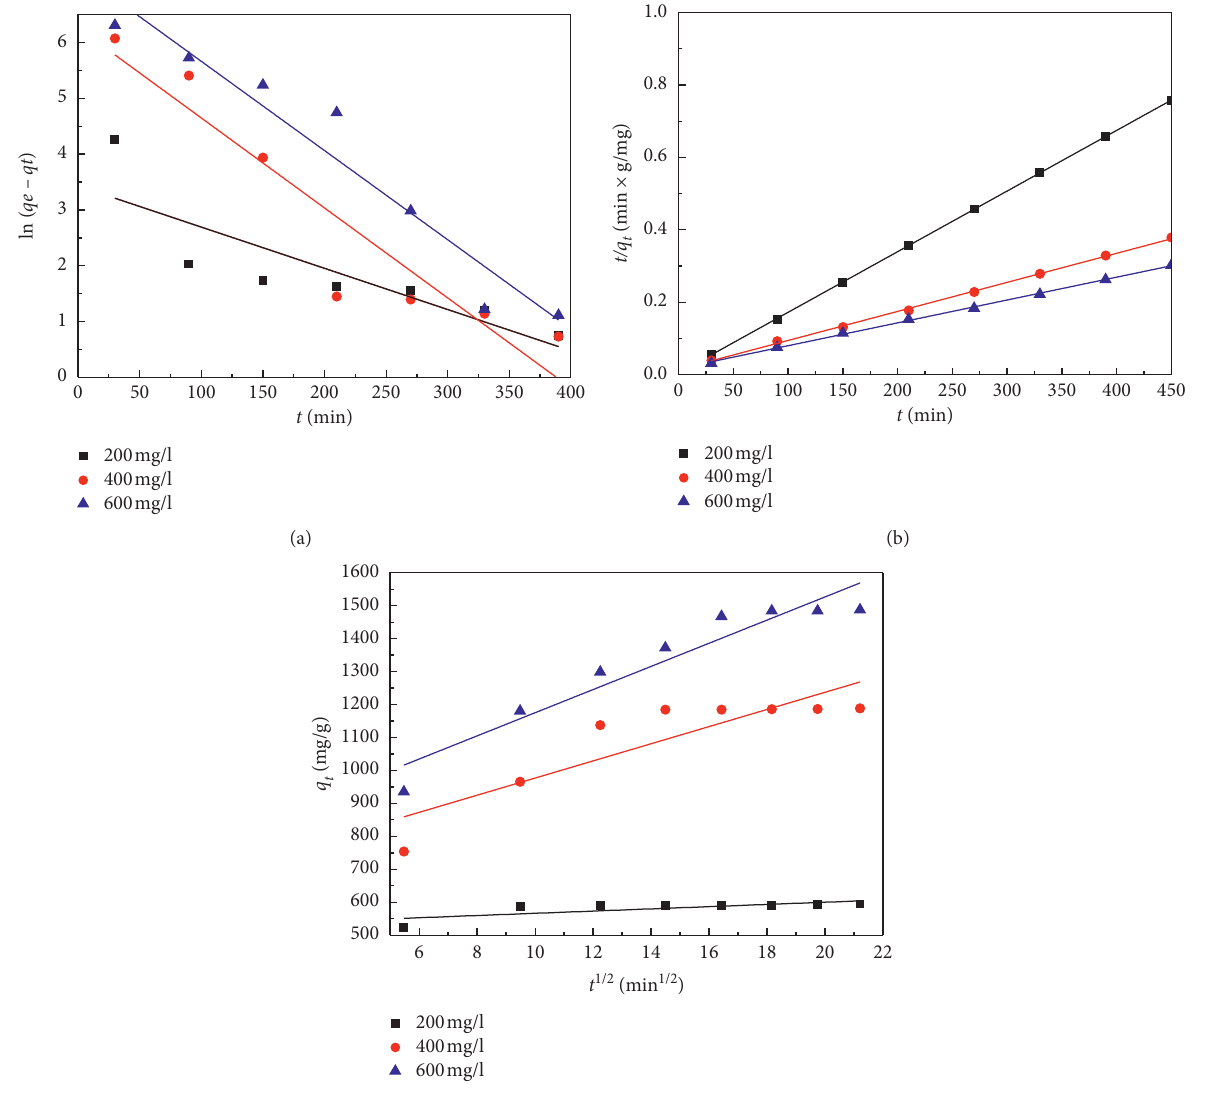
Figure 9: Adsorption kinetics of the AR88 adsorption by PPAC: (a) pseudo-first-order; (b) pseudo-second-order; (c) intraparticle